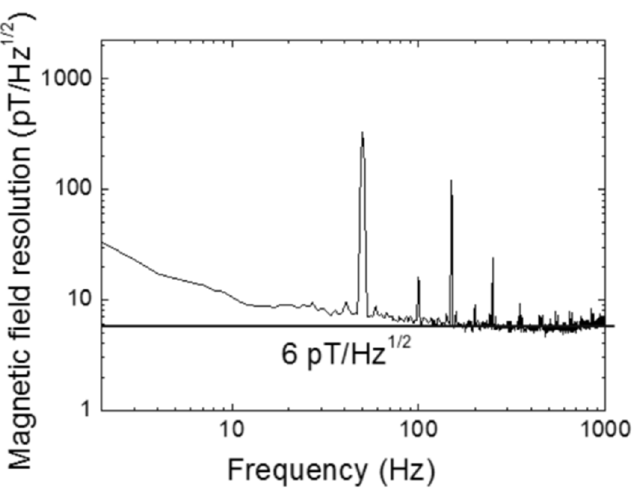
7 of 12 Figure 10. Magnetic response of the FeCoSiB amorphous wire magnetic sensor. Using a spectrum analyzer of HP89441A, the voltage noise spectrum of the output signal of the magnetic sensor Vn was measured. From Figure 7, Δ V/ Δ B was about 5 V/Gauss. The magnetic field noise spectrum Bn was calculated by Equation (5). Bn = Vn ΔV/ΔB.